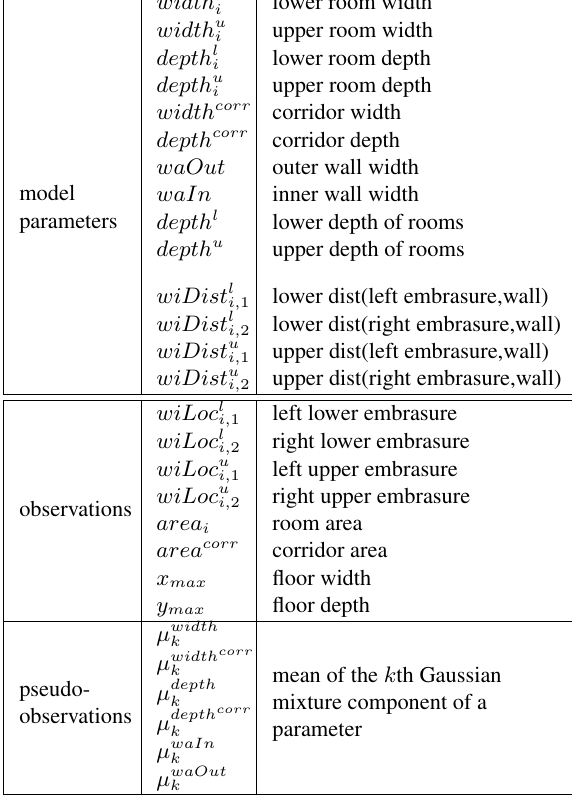
Table 1: Overview of the domain parameters, observations and pseudo-observations for floorplan model selection. The index i refers to the i th